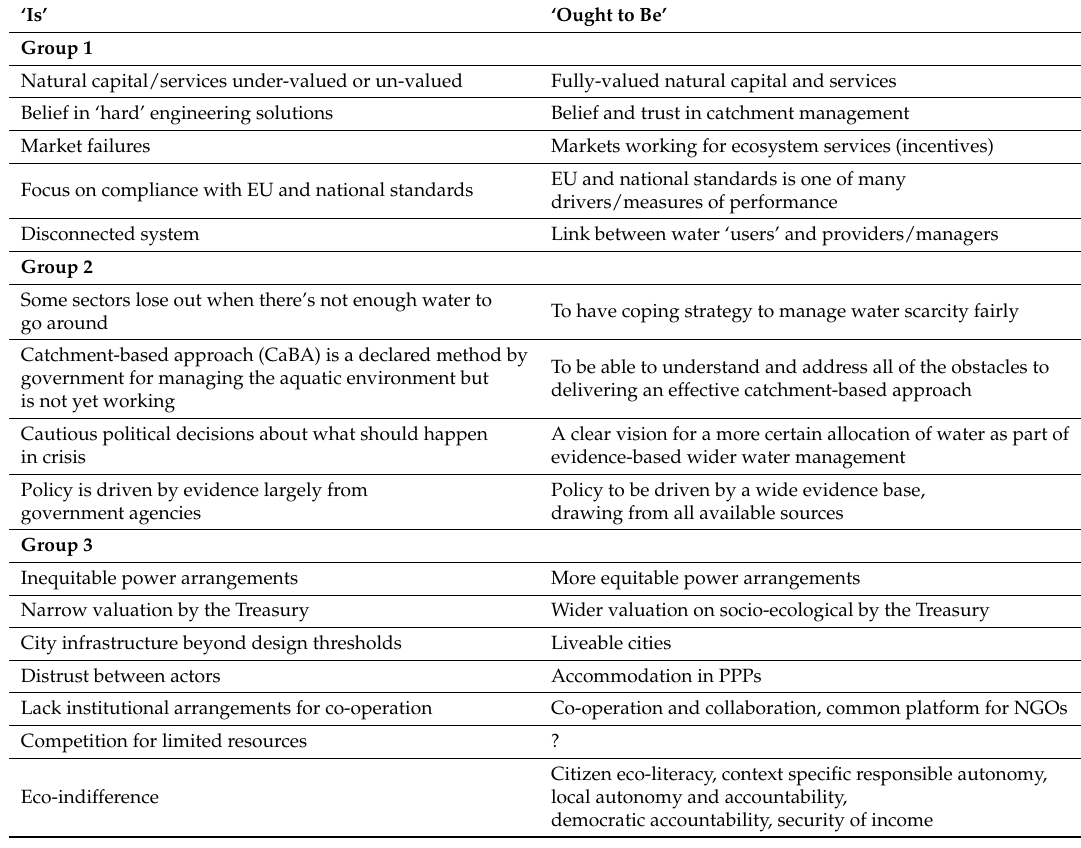
Table 3. ‘Is’ versus ‘ought to be’ in the context of water governance from the perspective of the workshop participants (redrawn from the versions created at the workshop)